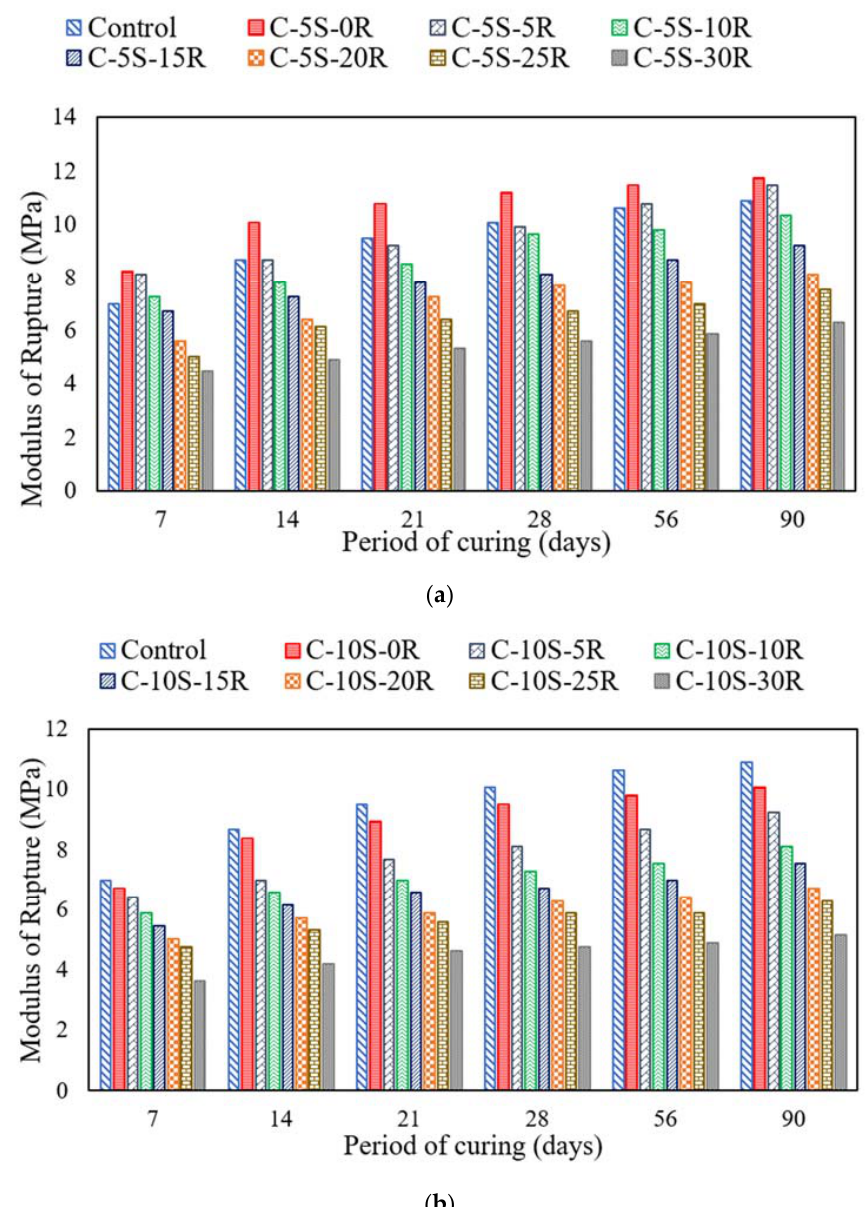
Figure 6. Flexural strength of specimens incorporating various proportions of SF and RHA. ( a ) C ‐ 5S ‐ (0 to 30)R, ( b ) C ‐ 10S ‐ (0 to 30)R.